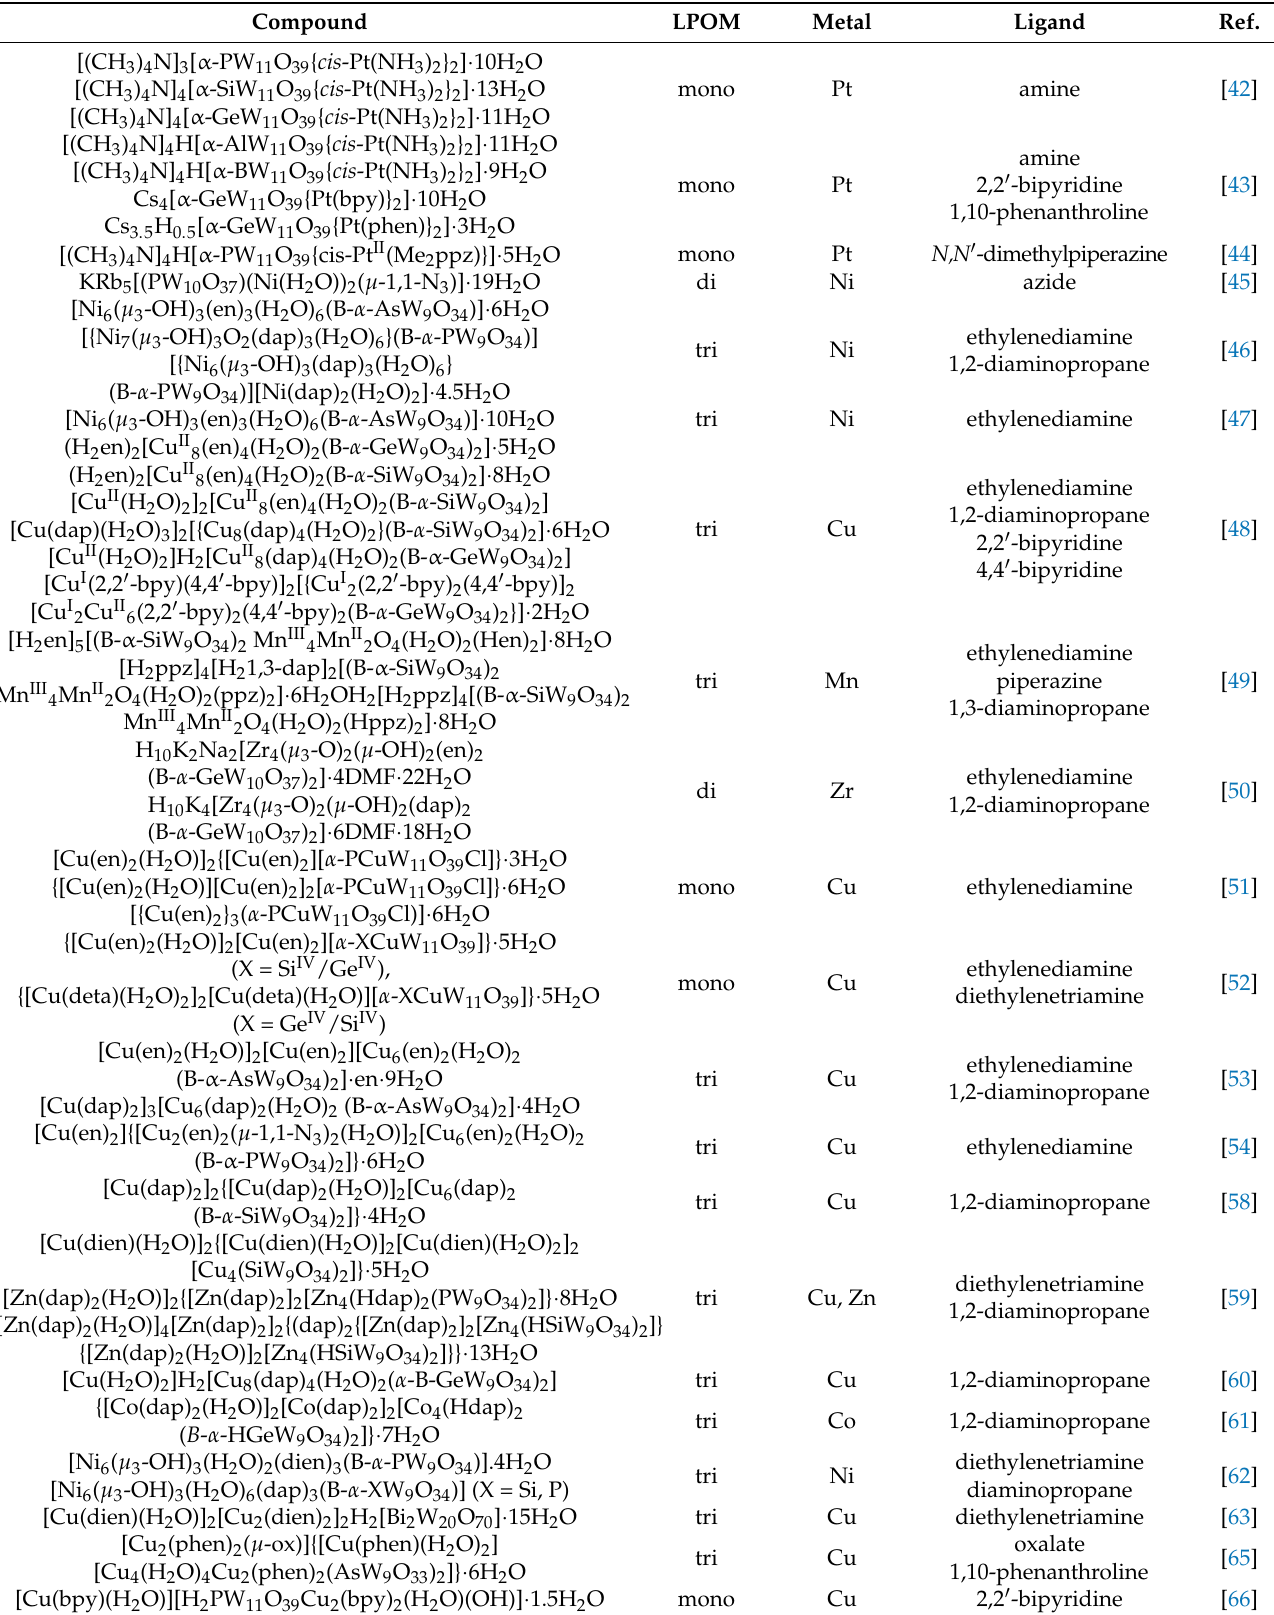
Table 1. Summary of inorganic–organic hybrids based on TMSPs with N-/O-donor ligands. Compound LPOM Metal Ligand